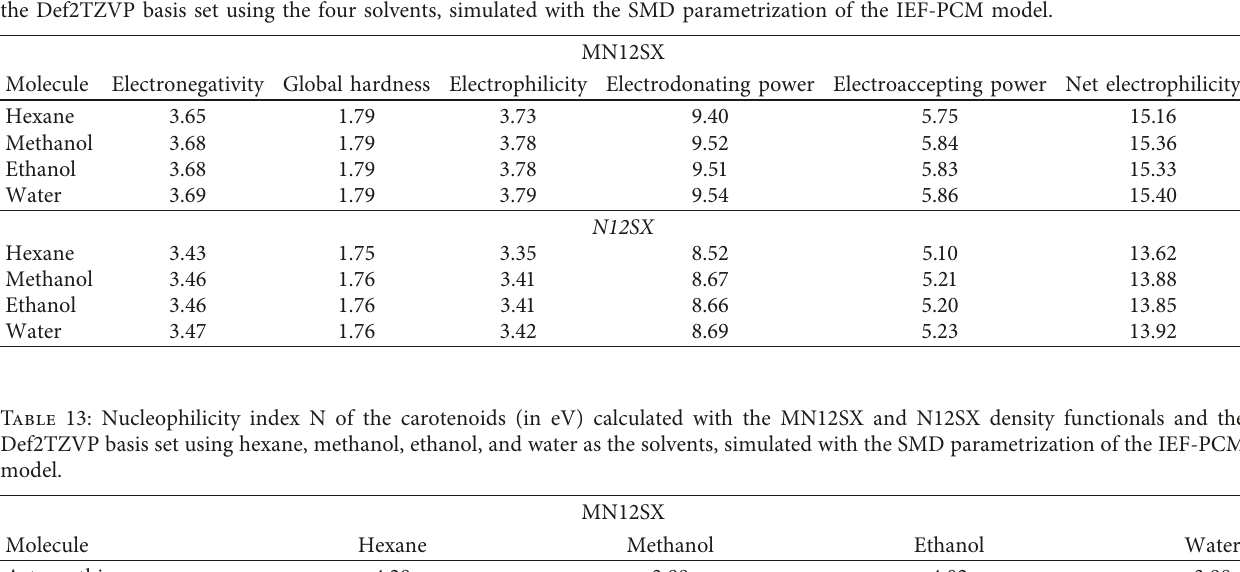
Table 12: Global reactivity descriptors (in eV) for the zeaxanthin pigment calculated with the MN12SX and N12SX density functionals and the Def2TZVP basis set using the four solvents, simulated with the SMD parametrization of the IEF-PCM model.